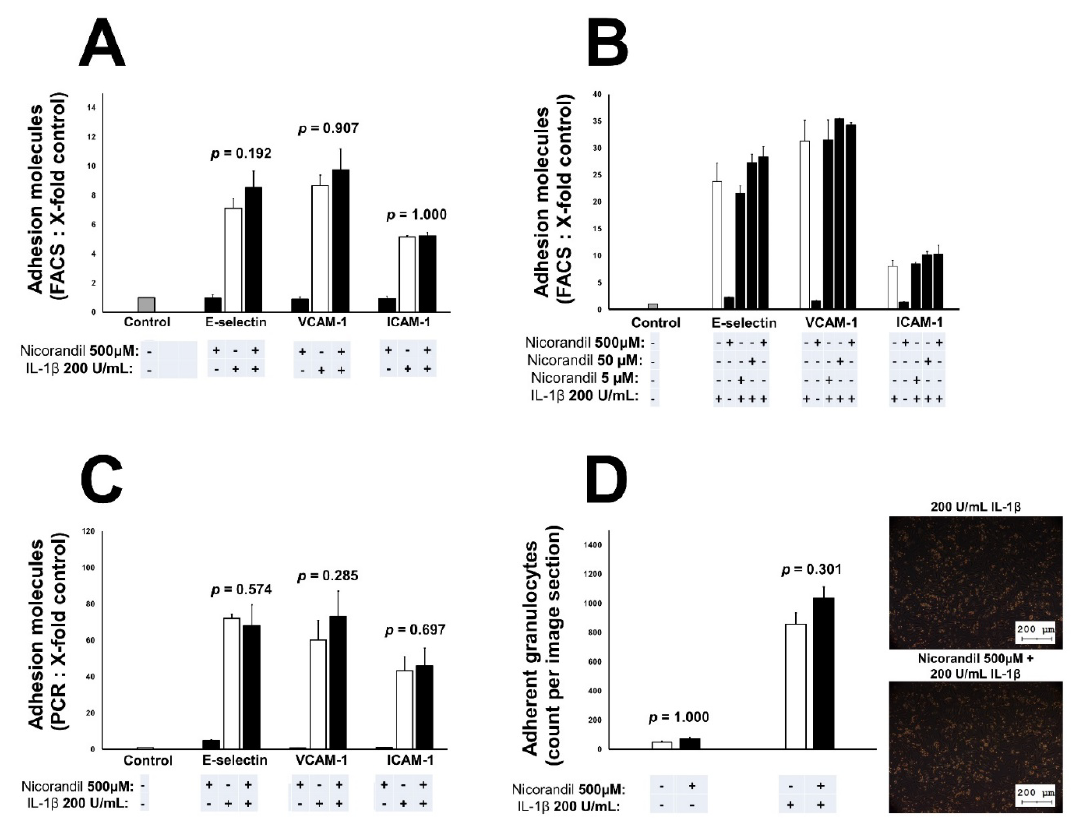
Figure 2. Effect of nicorandil treatment on adhesion molecules in endothelial cells. In endothelial cells, treatment with nicorandil (5 µM–500 µM) led to no difference in the expression of adhesion molecules 4 h after IL-1β stimulation (deter- mined by flow cytometry, ( A ) and ( B )). Similar findings were made for mRNA levels of E-selectin, VCAM-1, and ICAM-1, as they remained unchanged in endothelial cells 2 h after IL-1 β stimulation ( C ). Granulocytes adhesion did not differ in nicorandil pretreated endothelial cells compared to vehicle control 4 h after IL-1 β stimulation ( D ). All values given represent means ± standard deviations; the statistical significance of p ≤ 0.05 was considered significant.